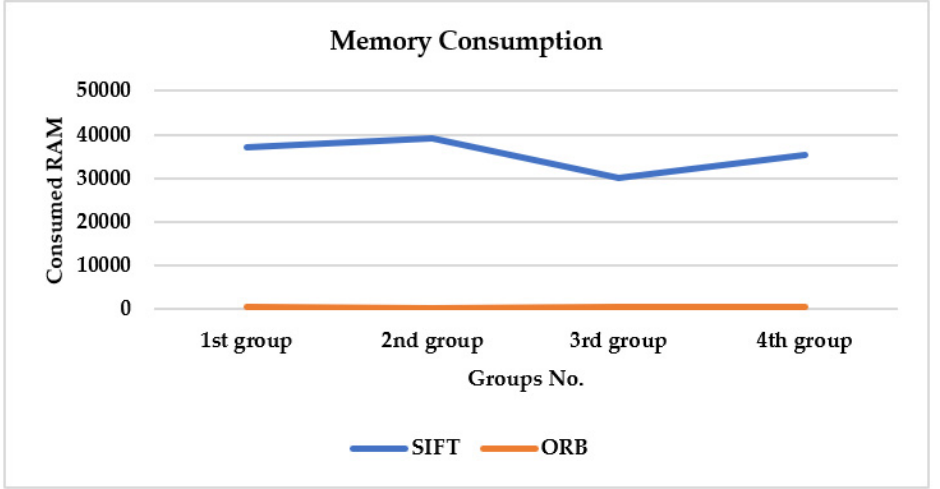
Figure 21. Average consumed memory for extracted features over the four groups created from TU Berlin dataset using methods based on handcrafted features.